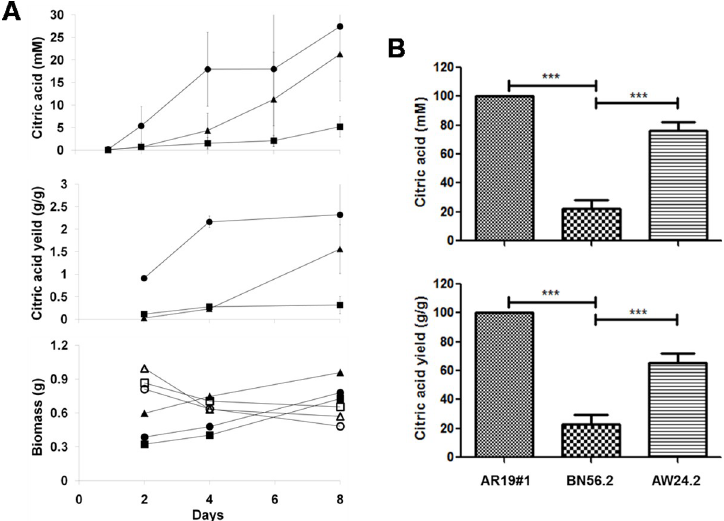
Fig 4. Citric acid production by A . niger . (A) The A . niger strains AR19#1 (•), BN56.2 ( ■ ) and AW24.2 ( ▲ ) were grown on fermentation medium (AM) and the citric acid in the spent medium (mM) and citric acid yield (per gram dry mycelia mass) are shown. Mycelial dry weights were measured for the strains AR19#1 (•), BN56.2 ( ■ ) and AW24.2 ( ▲ ) grown on AM and compared with corresponding data for growth on MM (respective open symbols; bottom graph). The error bars represent the data spread of five independent experiments. (B) Relative citric acid values (in percent) calculated from day 8 data for AR19#1, BN56.2 and AW24.2 strains are shown ( ��� p < 0.0001 with n = 5).